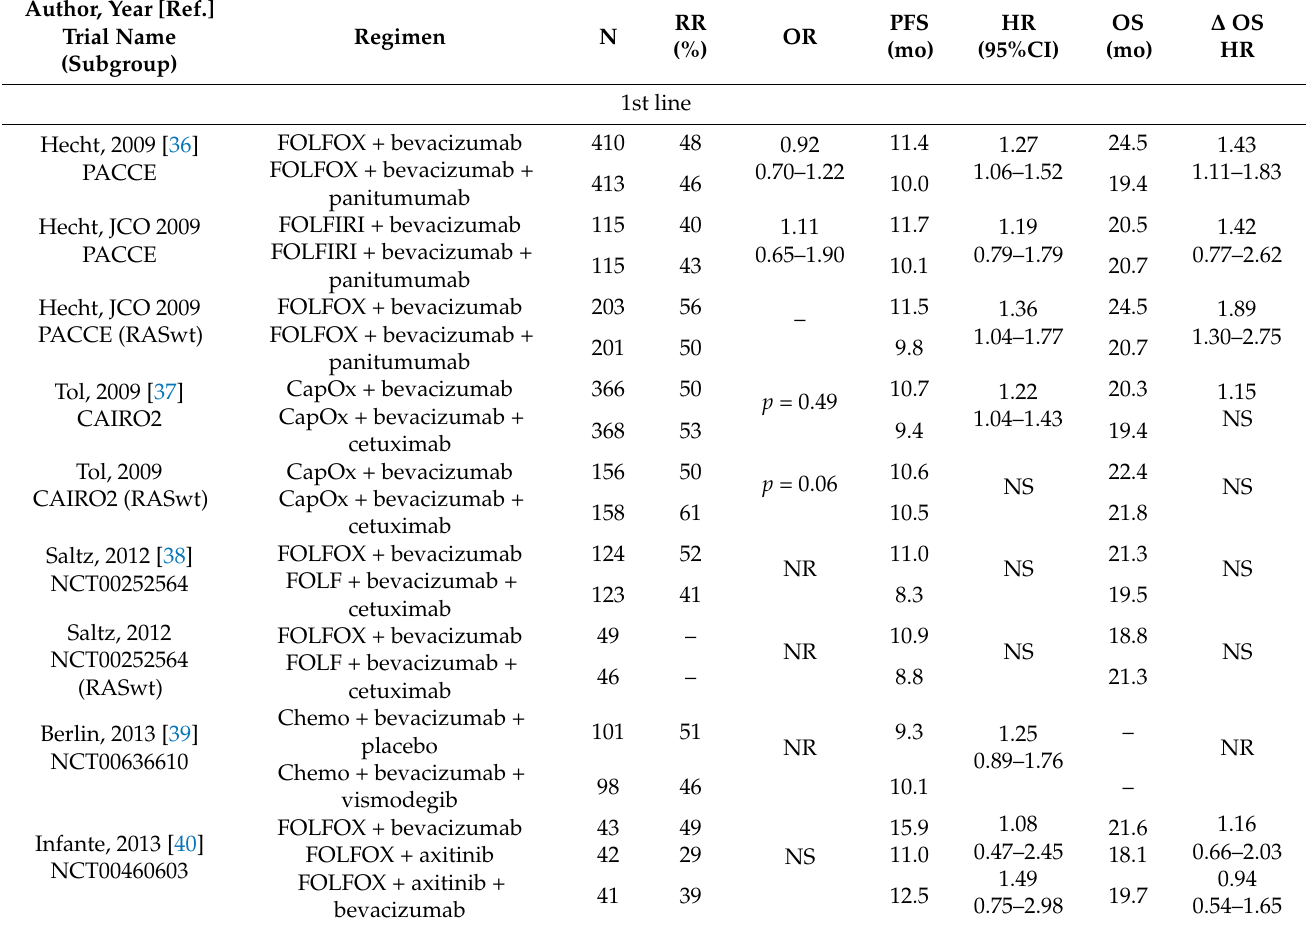
Table 3. Principal randomized trials comparing first line combination chemotherapy with single or double targeted